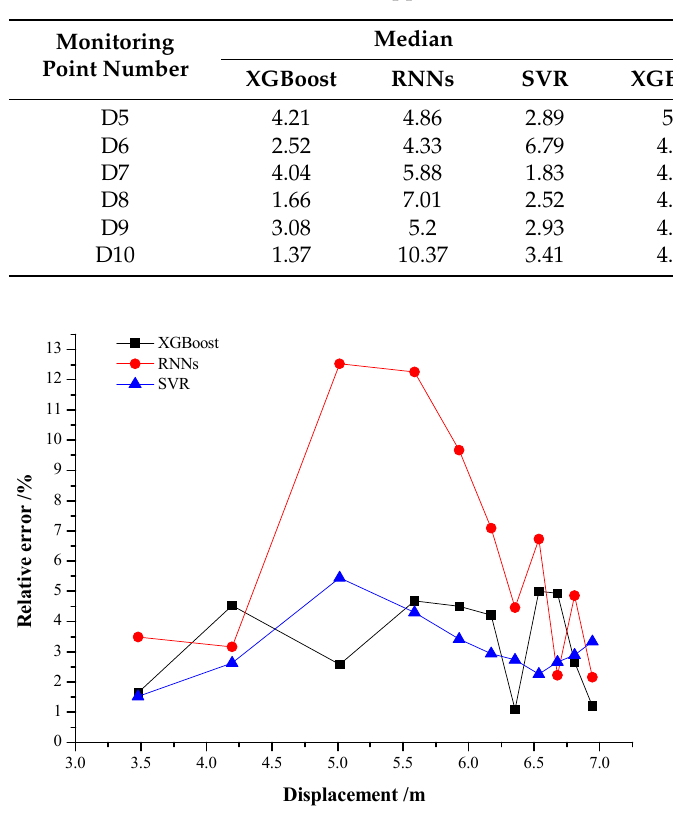
Figure 12. Variation of RE with slope displacement of D5.